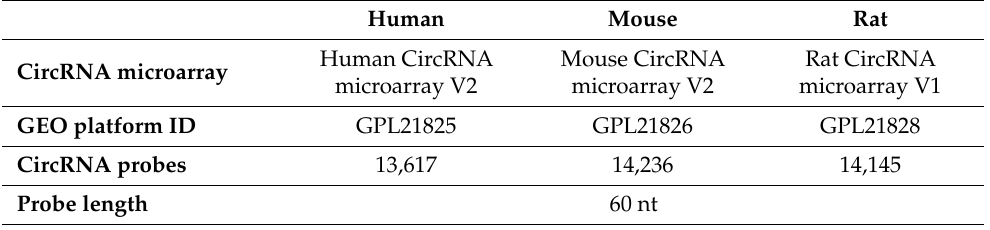
Table 1. CircRNA collections on the circRNA